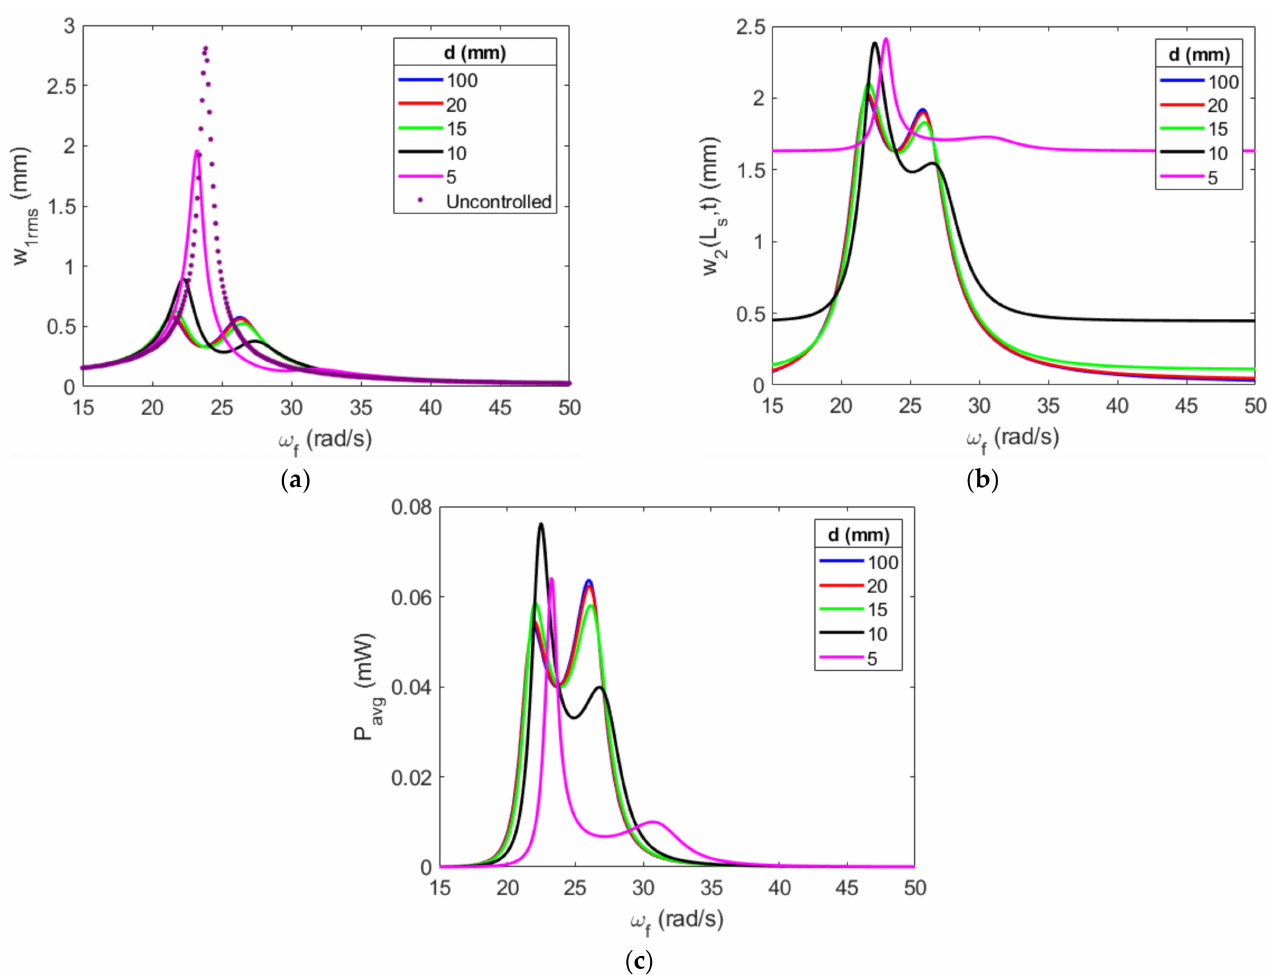
Figure 14. Response of the single repulsive configuration for the ( a ) primary structure, ( b ) absorber’s displacement ( c ) and average power